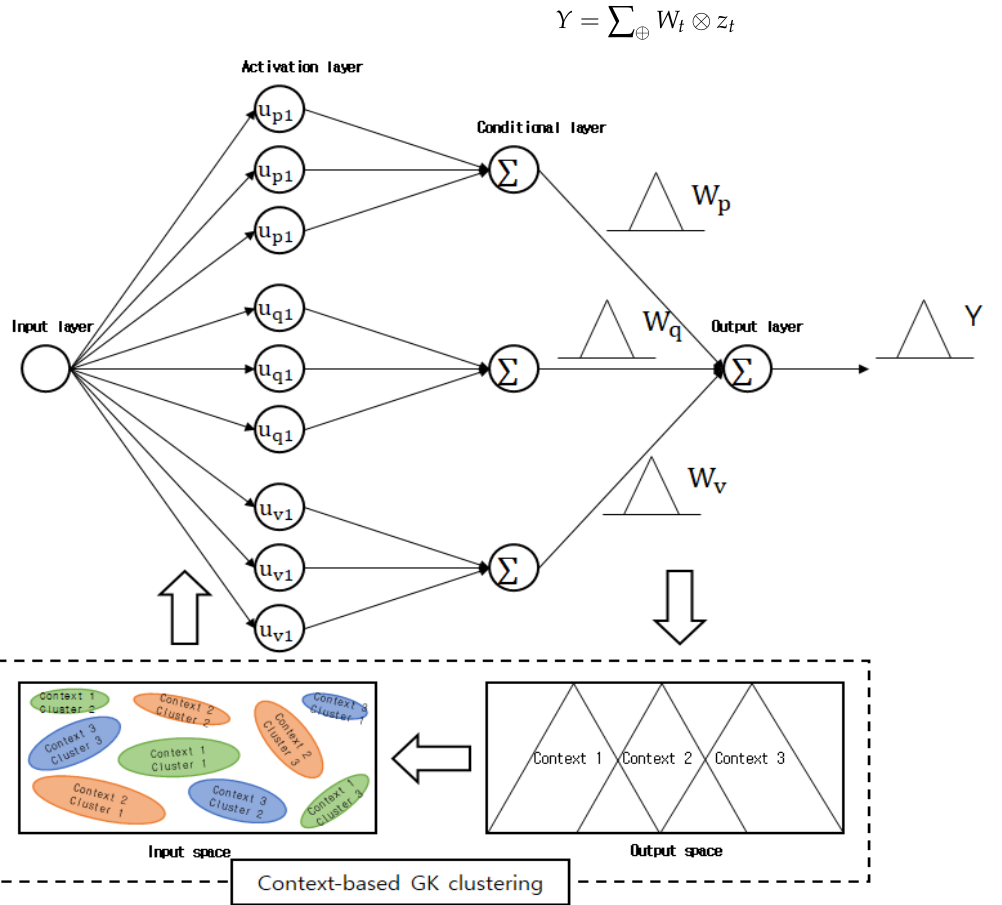
Figure 10. CGK-based granular model